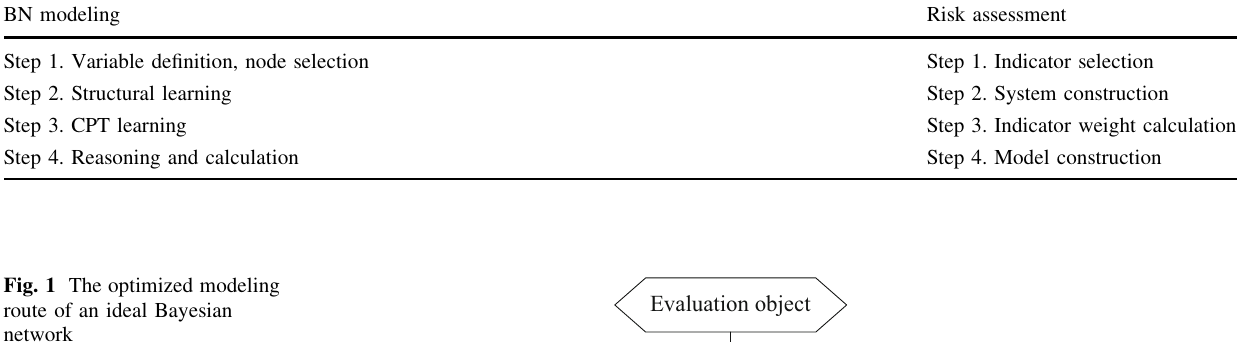
Fig. 1 The optimized modeling route of an ideal Bayesian